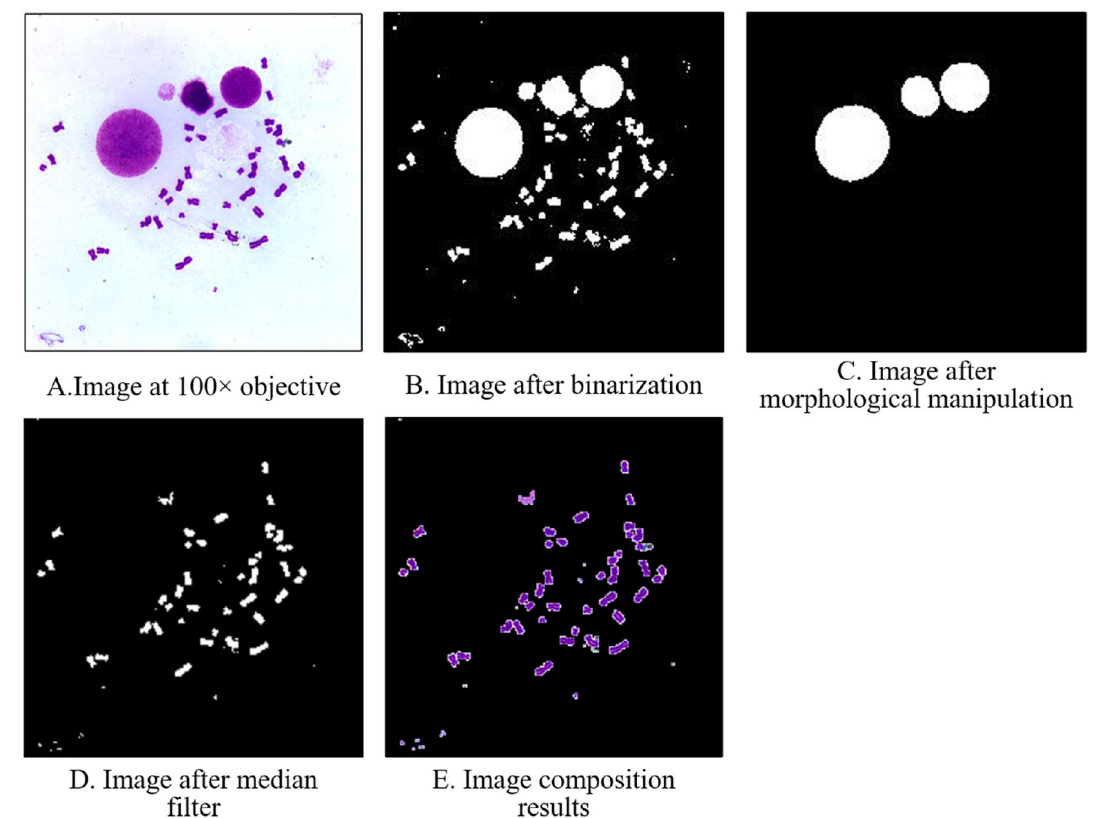
Figure 4. Process of the chromosome extraction